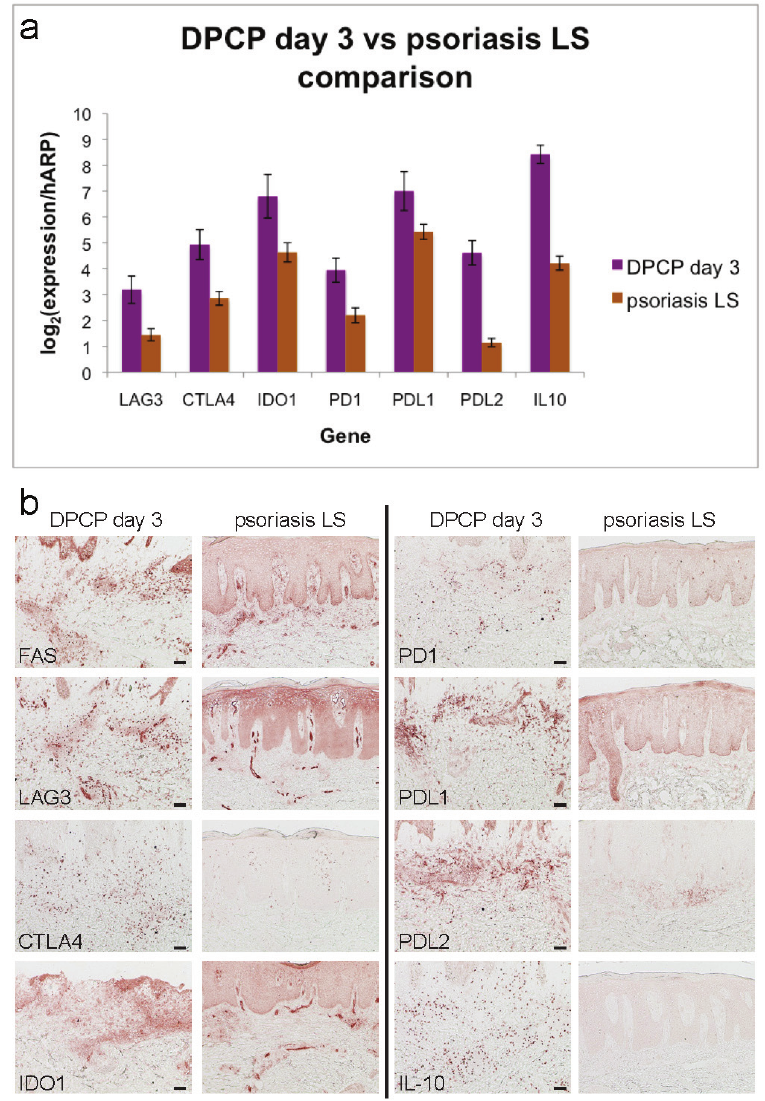
Figure 2. Psoriasis lesional skin has lower expression of various negative immune regulators than DPCP day 3 reactions by both qRT- PCR and immunohistochemical approaches. ( a ) qRT-PCR analysis for negative regulators LAG3, CTLA4, IDO1, PD1, PDL1, PDL2, and IL-10. Shown are average normalized expression values for DPCP day 3 samples (n=11, purple bars) and psoriasis lesional skin (LS) samples (n=11, brown bars). All except PDL1 are p <0.05 by unpaired two-tailed t -test assuming equal variance. Error bars represent standard errors of the mean. ( b ) Immunohistochemistry showing increased protein expression of negative regulators in DPCP day 3 samples compared to psoriasis LS. Shown are stains with antibodies specific to the indicated targets. Scale bar = 100 μm (applies to all